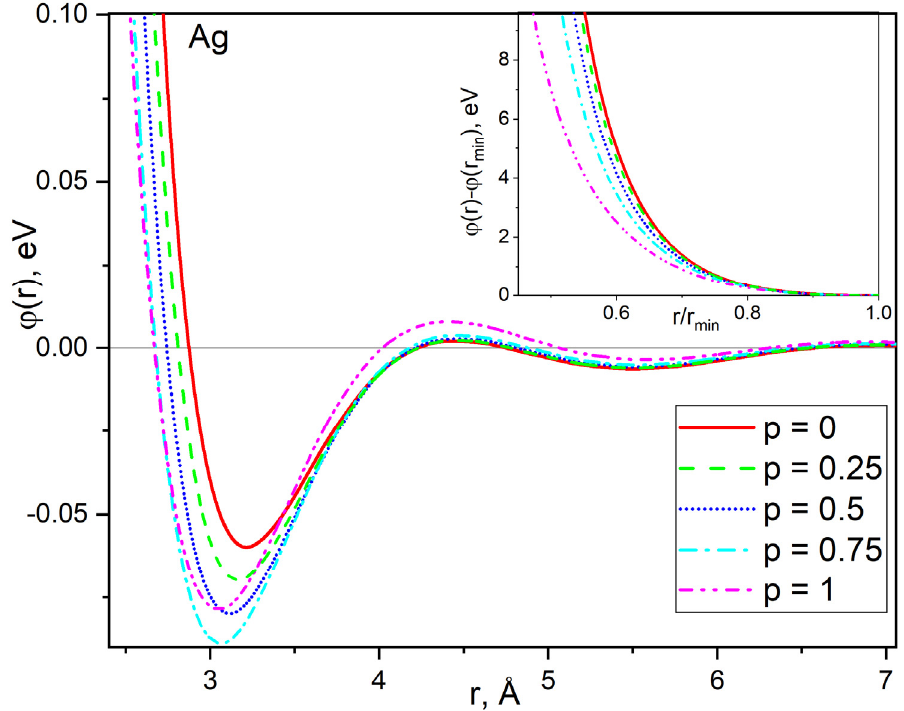
Figure 5. Pair potentials for liquid Ag at T = 1273 K and different p . Inset: the repulsive part of ϕ ( r ) in reduced units.